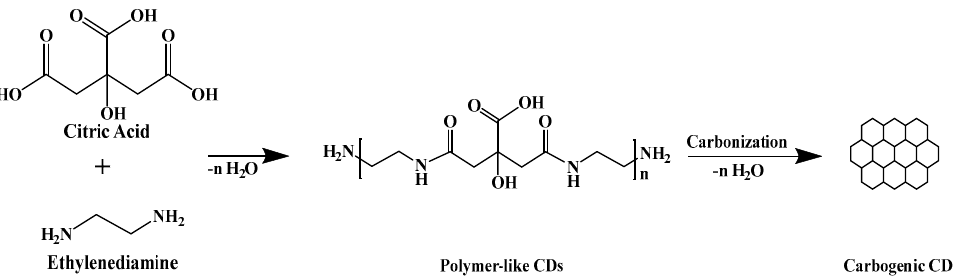
Figure 2. Schematic of condensation polymerization and carbonization of CA and EDA.